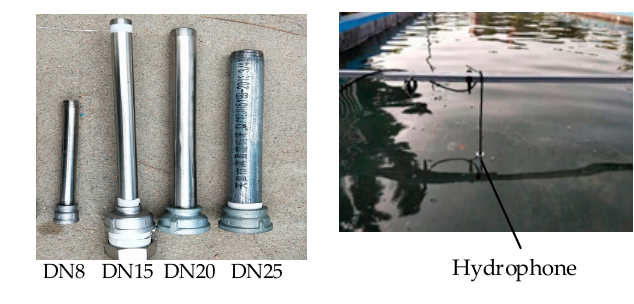
Figure 7. Test on site. Table 2. Leak hole diameter.